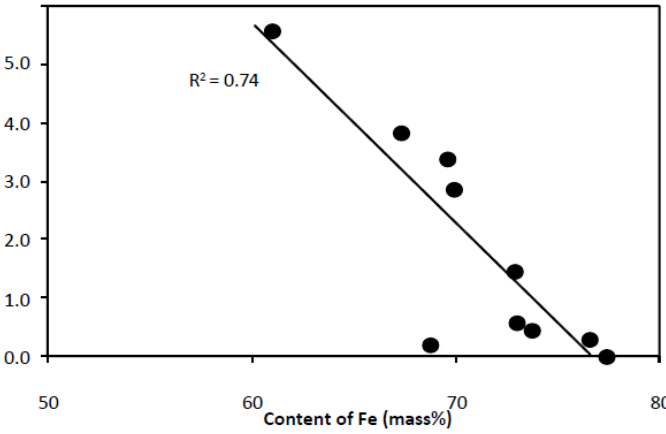
Figure 4. Differentiation of Fe and Cu content in wustite.